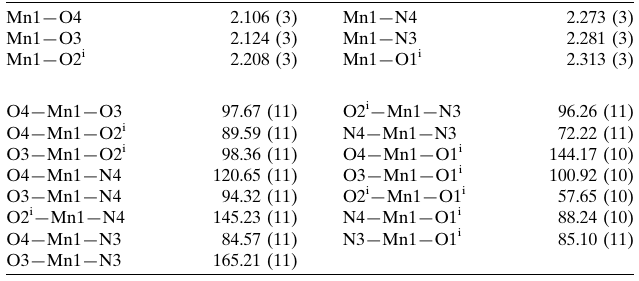
Selected geometric parameters (A˚ , (cid:2)